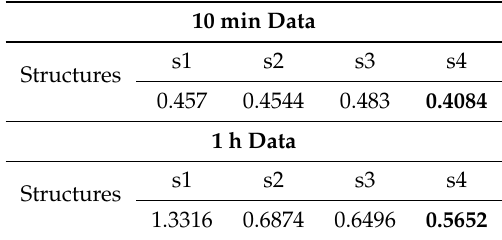
Table 7. Single BP model selection for wind speed time series at the AH site (MAE).